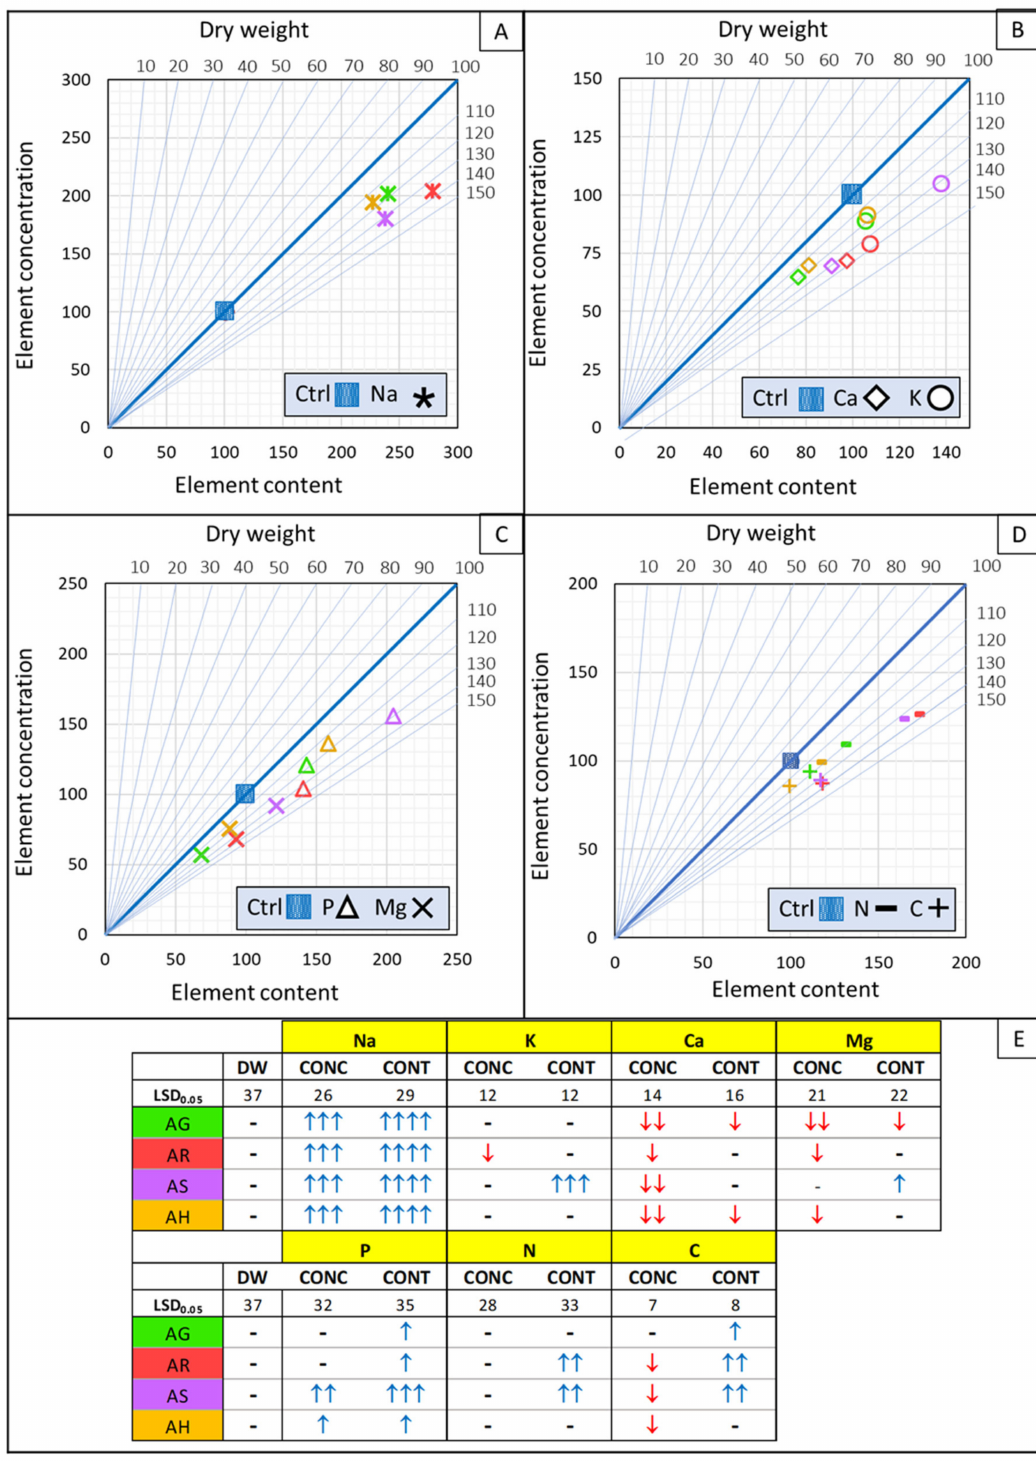
Figure 5. Vector analysis showing directional changes in Atriplex spp. dry weight and ( A ) Na content and concentration, ( B ) K and Ca content and concentration, ( C ) Mg and P content and concentration, ( D ) N and C content and concentration. Dry weight and element content and concentration are expressed as relative data with respect to the Ctrl treatment, which is set at 100% and is indicated by a blue square; the colours of the element symbols are related to the four genotypes, as shown in the ensuing interpretation of the directional changes in relative dry weight (DW) and element concentration and content with respect to the reference treatment (Ctrl) ( E ). Upwards and downwards arrows indicate significant changes, and ( - ) indicates insignificant changes. The number of arrows indicate an increasing amplitude of the variation (from >1 to >4